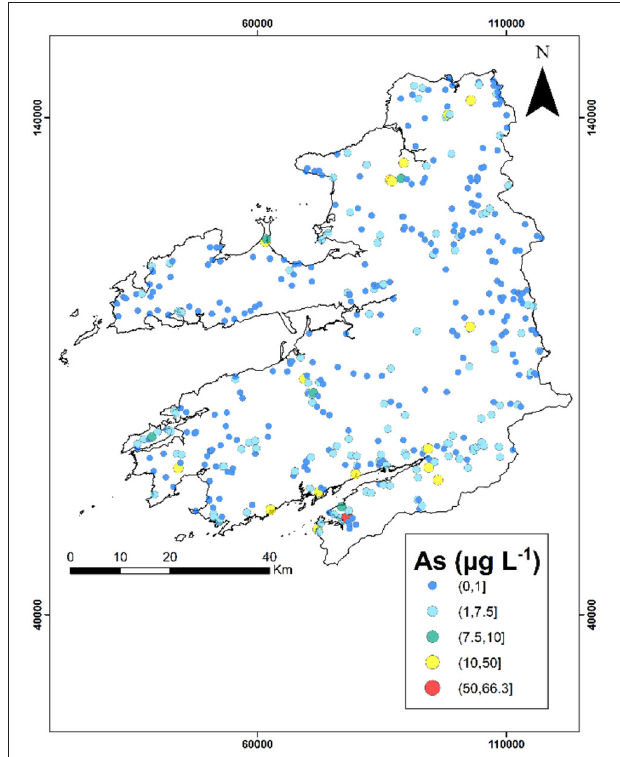
FIGURE 3 | Spatial distribution of arsenic divided into five